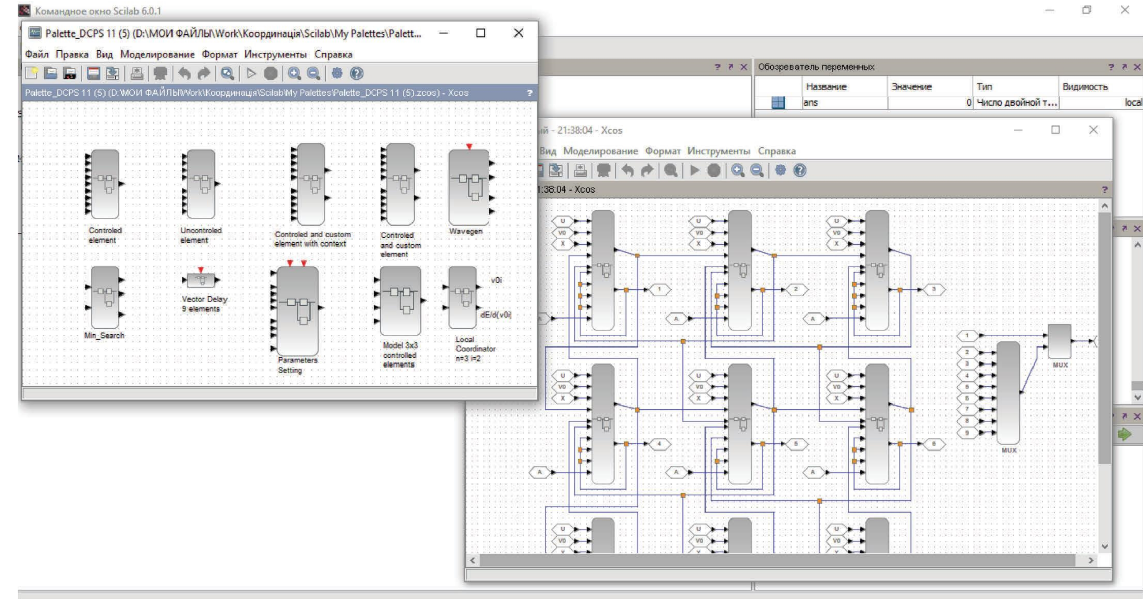
Figure 5: Simulation module library and the temperature coordination control